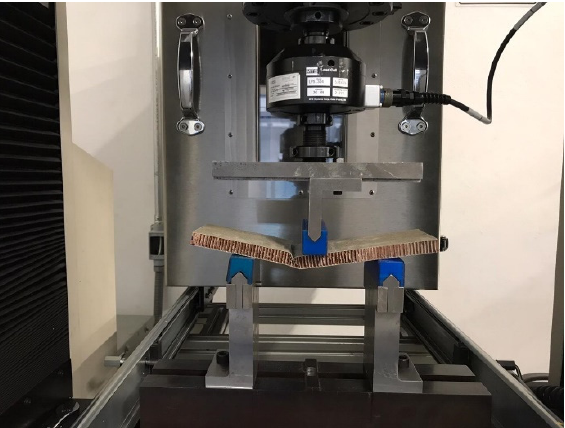
Figure 2. Photograph corresponding to the arrangement for the flexural test in reference panels according to the ASTM C393/C393M-20 standard.